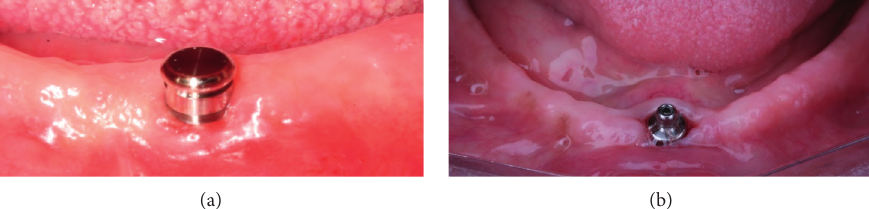
Figure 3: (a) CM-LOC attachment. (b) Ball attachment.